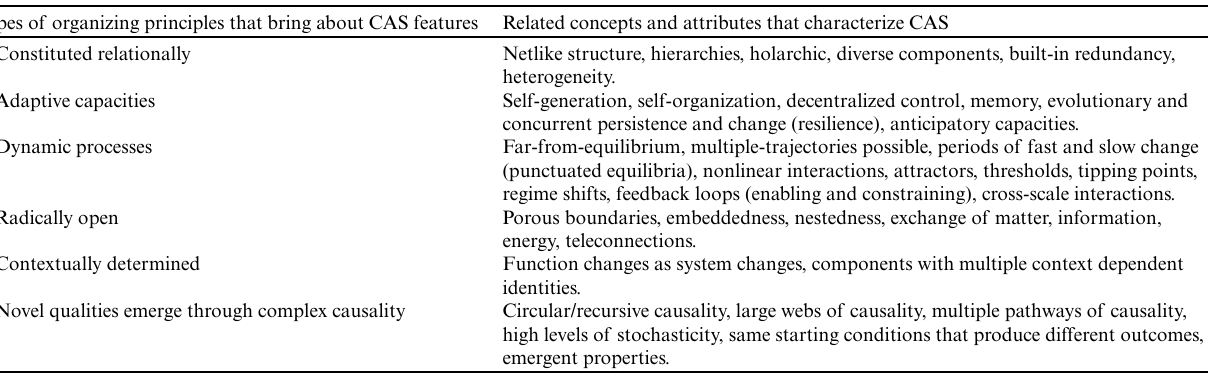
Table 2 . Conceptual typology of the general underlying organizing principles of complex adaptive system (CAS) features. Types of organizing principles that bring about CAS features Related concepts and attributes that characterize